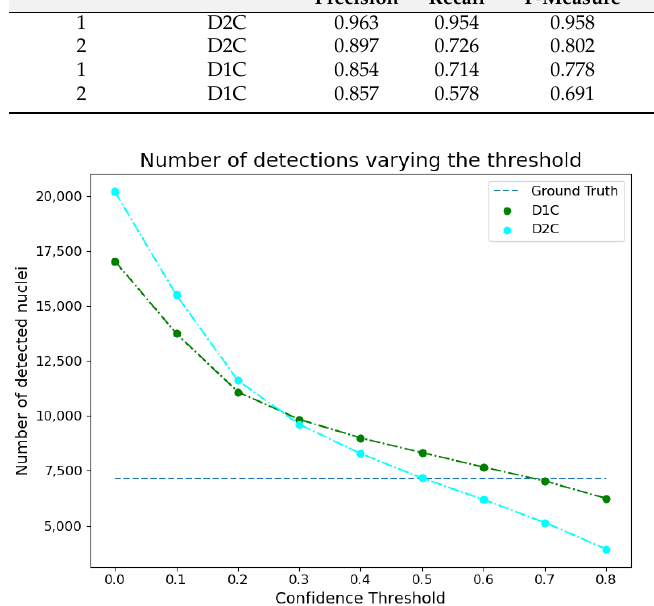
Figure 4. Experimental analysis for finding the best confidence